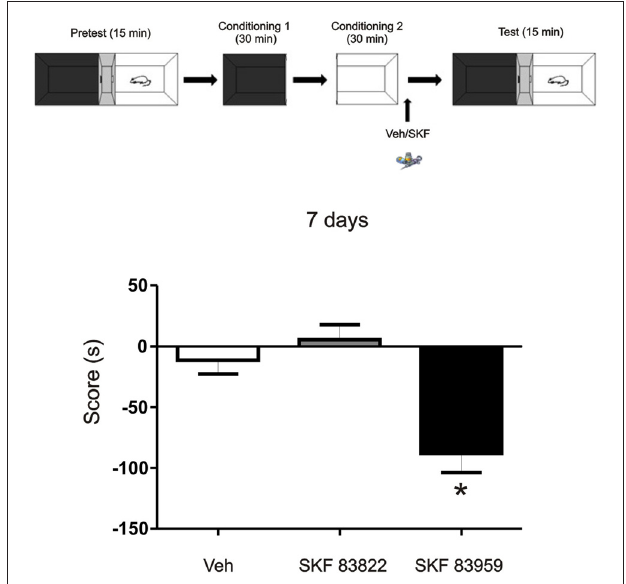
FIGURE 6 | The aversive effect observed is mediated through the activation of dopamine (DA) receptor D5 in the mPFC. Animals were infused with the selective D1R dopaminergic agonist SKF 83822, with selective dopaminergic agonist SKF 83959 or Vehicle in the mPFC region immediately after the exposure to the white compartment of the apparatus. Test was performed 7 days later. Animals infused with SKF 83959 showed an aversive behavior ( p = 0.047, n = 8–19) while the animals infused with SKF 83822 showed no changes in preference or aversive behavior ( p > 0.05, n = 8–19). ∗ p <